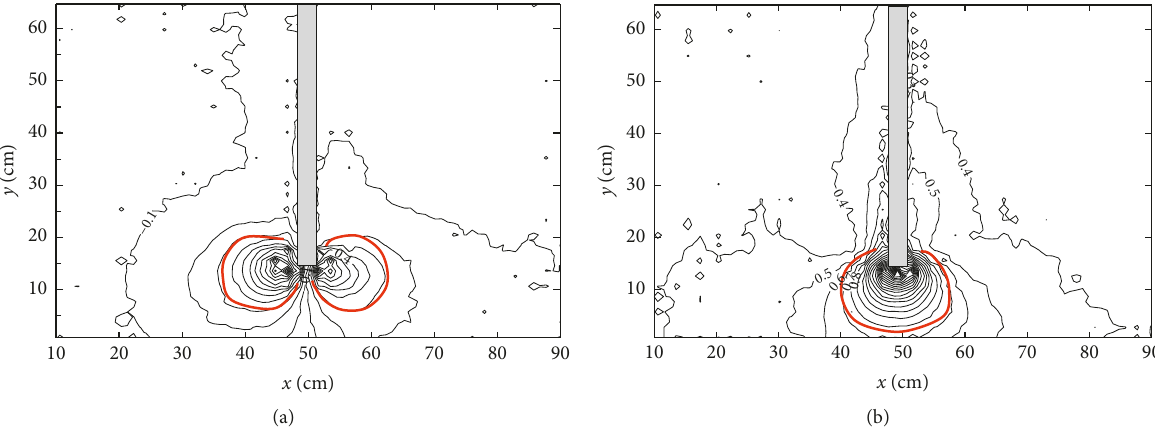
Figure 10: Displacement contours of the sand around a single pile. (a) Horizontal displacement. (b) Vertical